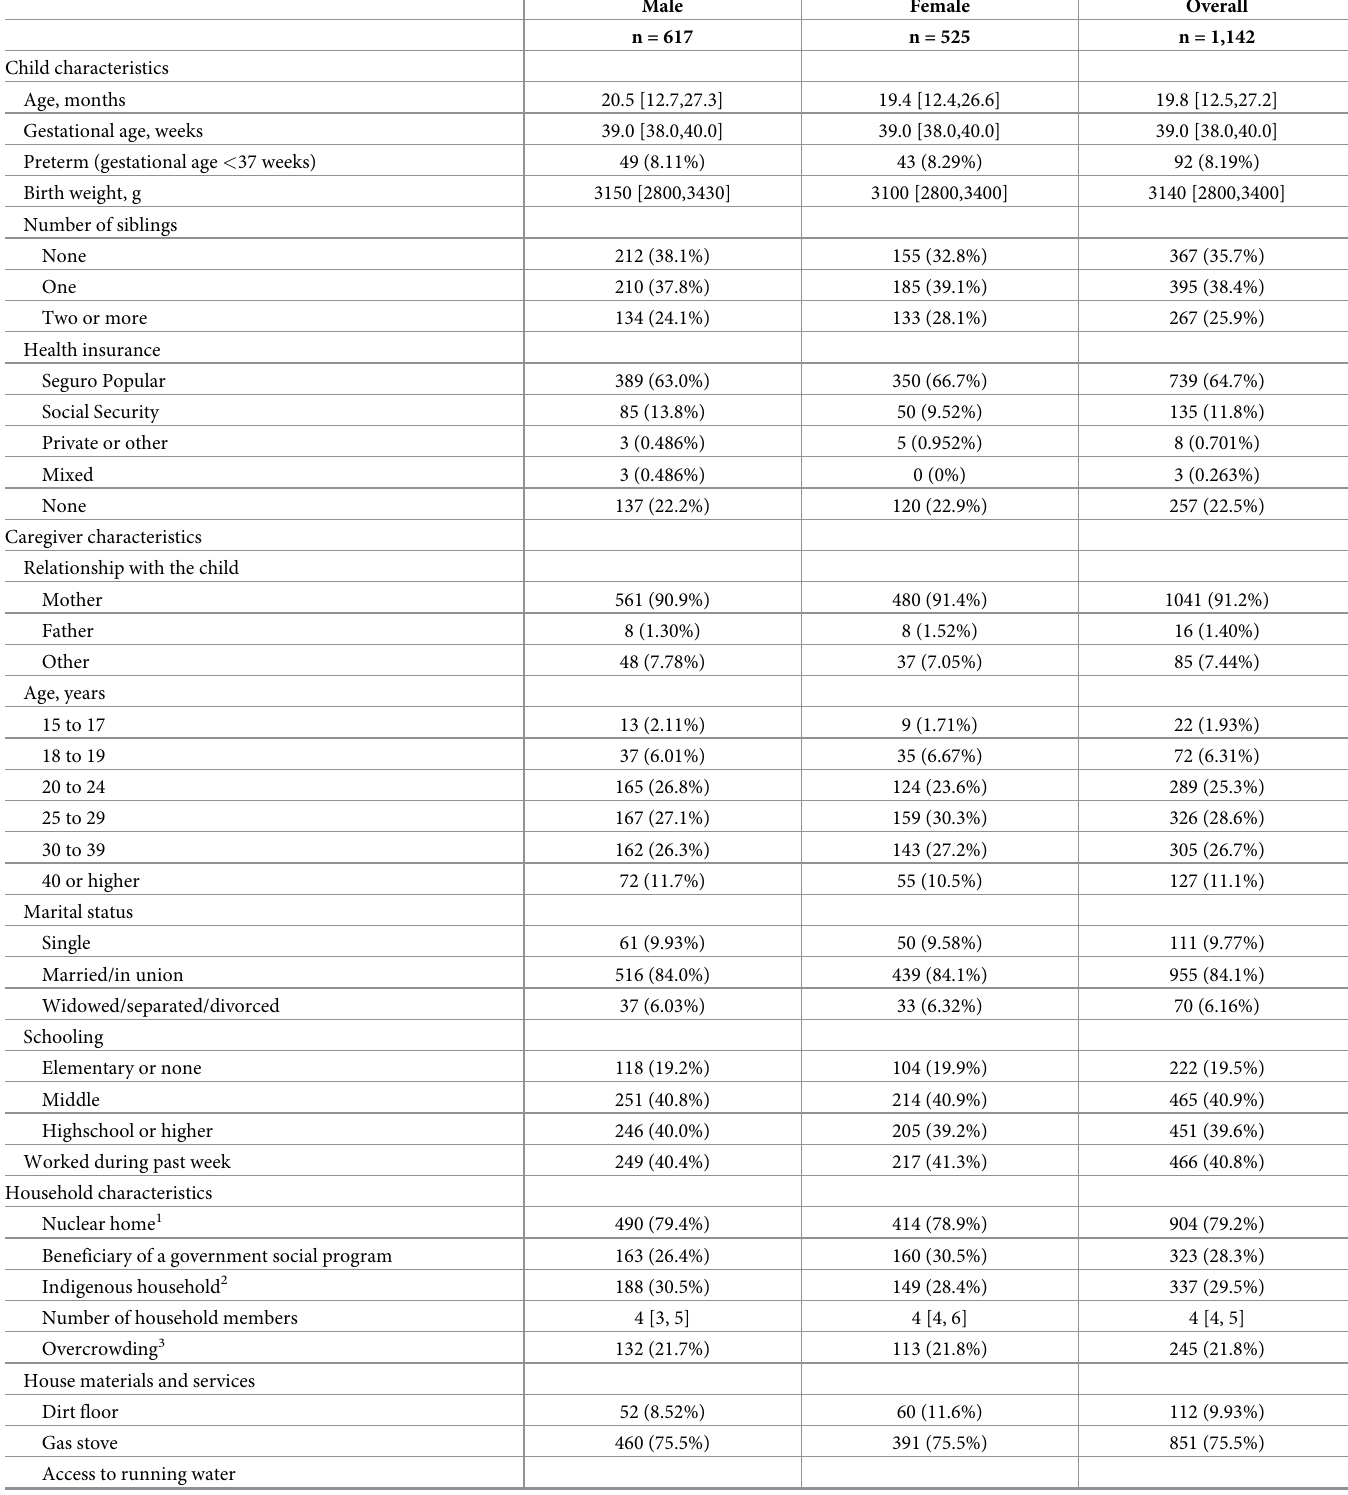
Table 1. General and sociodemographic characteristics of the analytical sample by